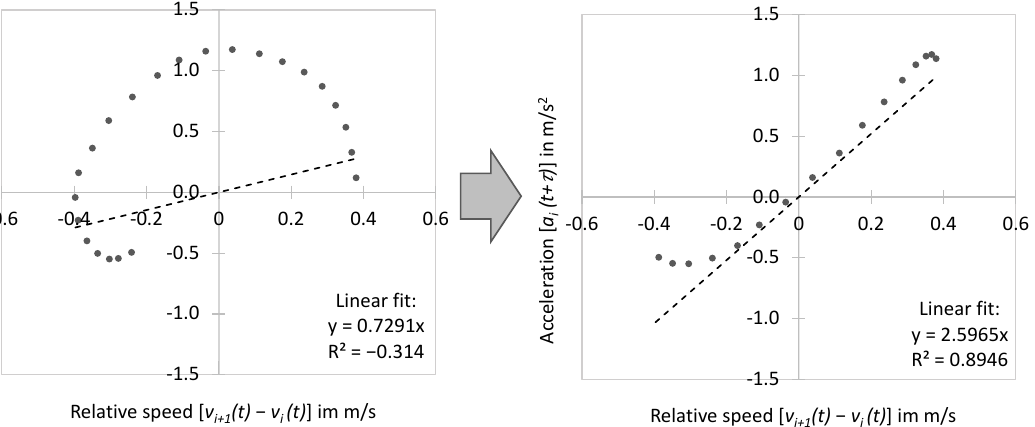
Figure 3. Relative speed versus acceleration plots for an individual pedestrian without and with a time lag.